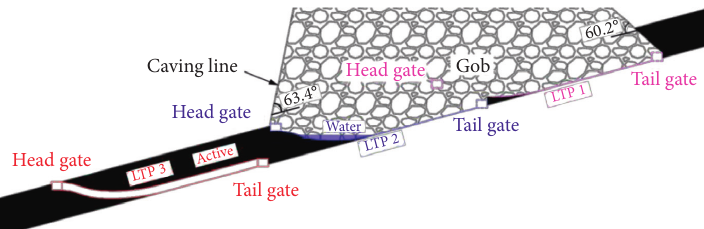
Figure 25: Schematic of surrounding rock mass after extraction of LTP 1 and LTP 2 panel (not strictly to